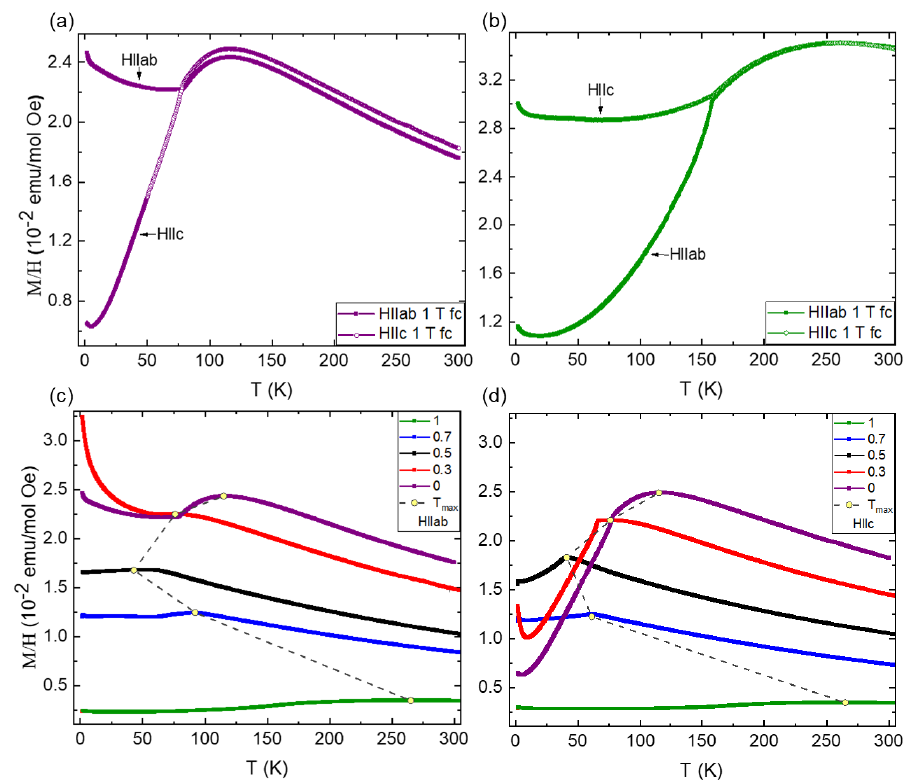
Figure 7. Magnetization as a function of temperature for a field of 1 T ( a ) for Mn 2 P 2 S 6 , ( b ) for Ni 2 P 2 S 6 together with an overview of the magnetization as a function of temperature for the full series (Mn 1 − x Ni x ) 2 P 2 S 6 measured in a field of 1 T applied ( c ) H || ab and ( d ) H || c .